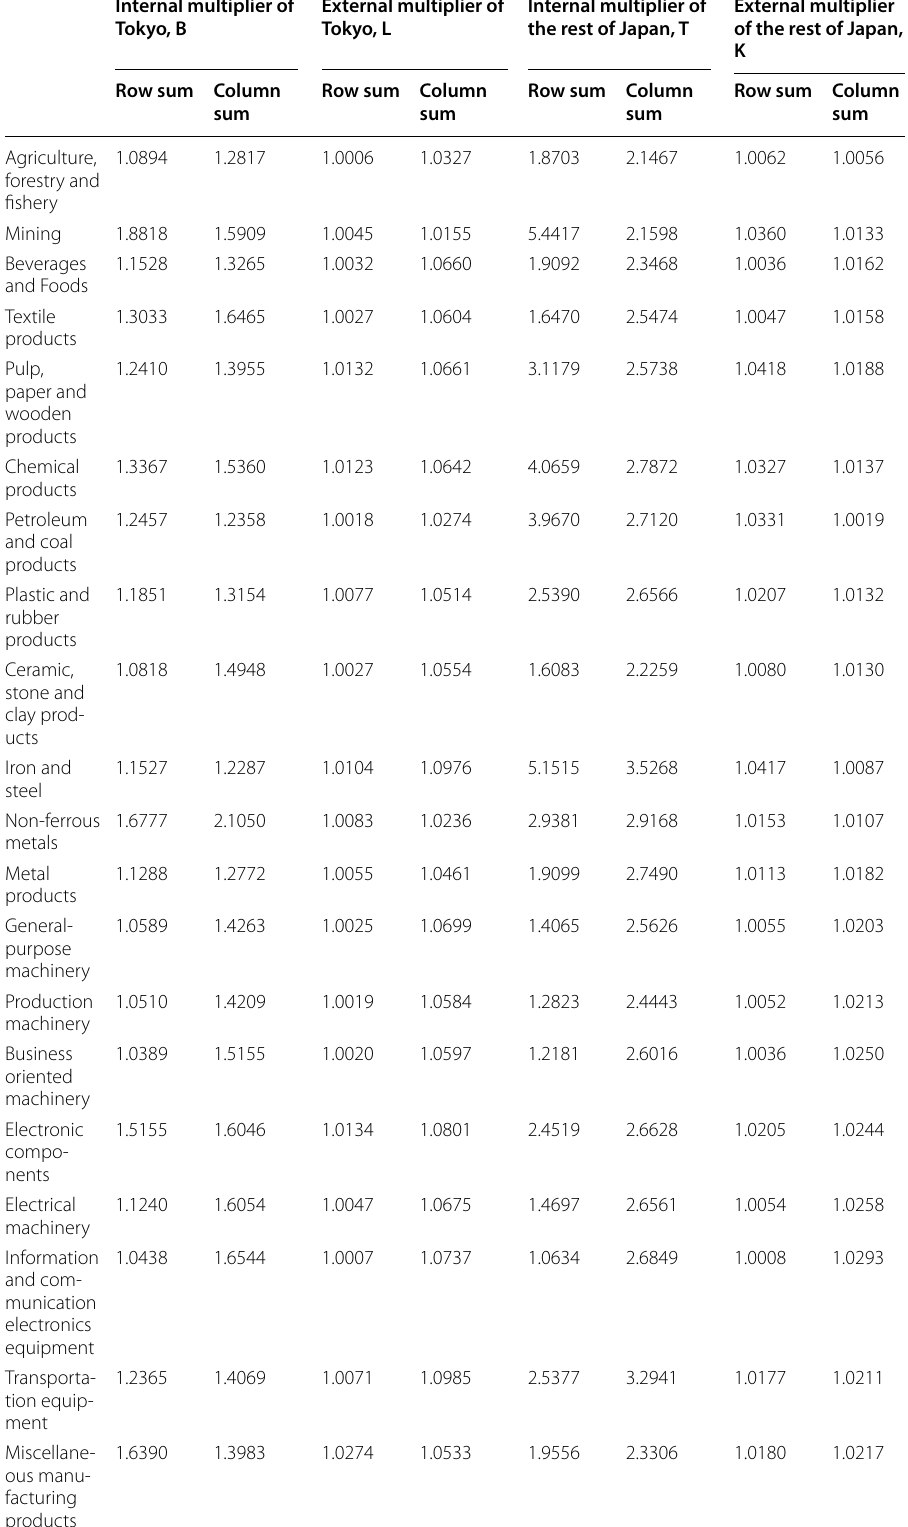
Table 1 Summary of internal and external multipliers of Tokyo and the rest of Japan Internal multiplier of External multiplier of Internal multiplier of External multiplier Tokyo, B Tokyo, L the rest of Japan, T of the rest of